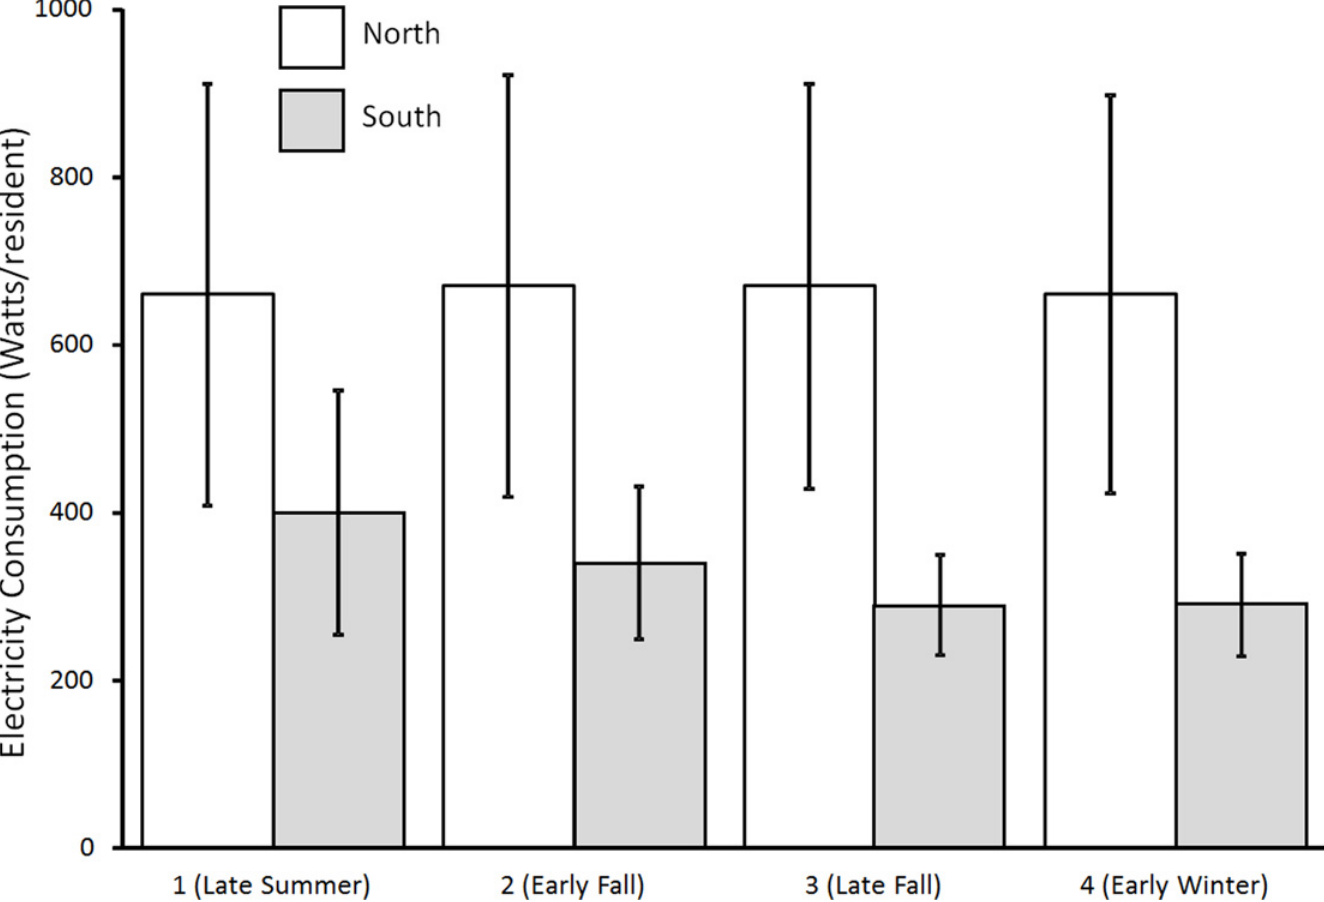
Fig 2. Seasonal per capita patterns in electricity use in dormitories above ( “ North ” ) and below ( “ South ” ) 41.6°N latitude during the fall of 2011 when there were no competitions. Error bars are 95% confidence